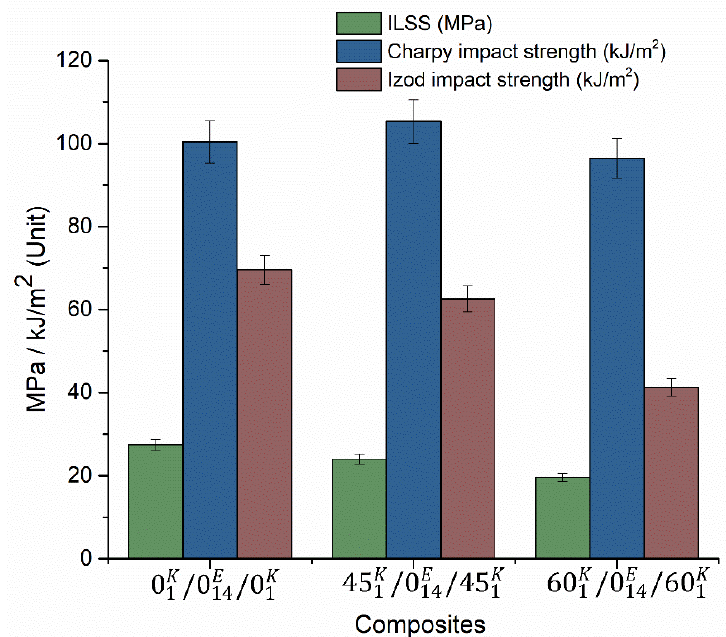
Figure 5. Impact strength and ILSS.